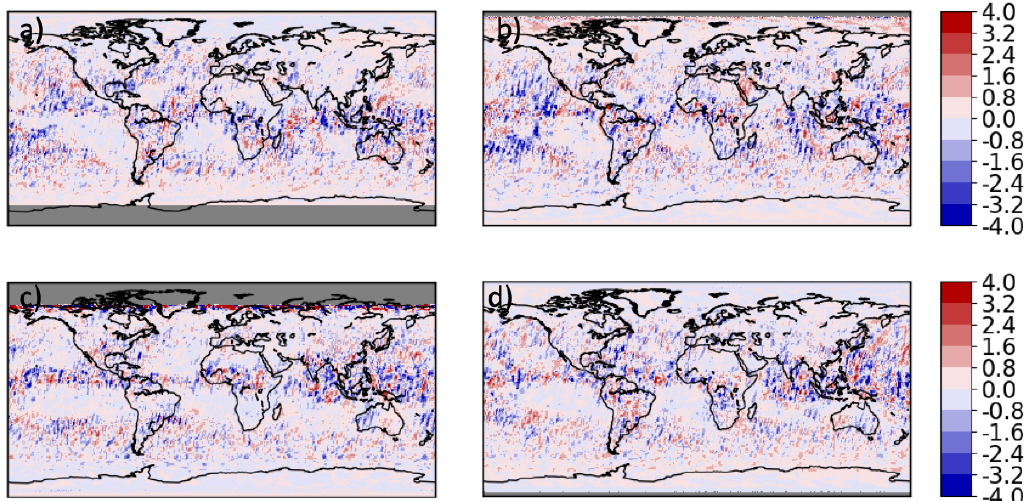
Figure 9. Monthly mean nighttime LW flux difference between using all footprints and only using footprints with viewing zenith angles less than 66 ◦ for January ( a ), April ( b ), July ( c ), and October ( d ) 2014 from CERES NPP observation. Regions in grey only have daytime